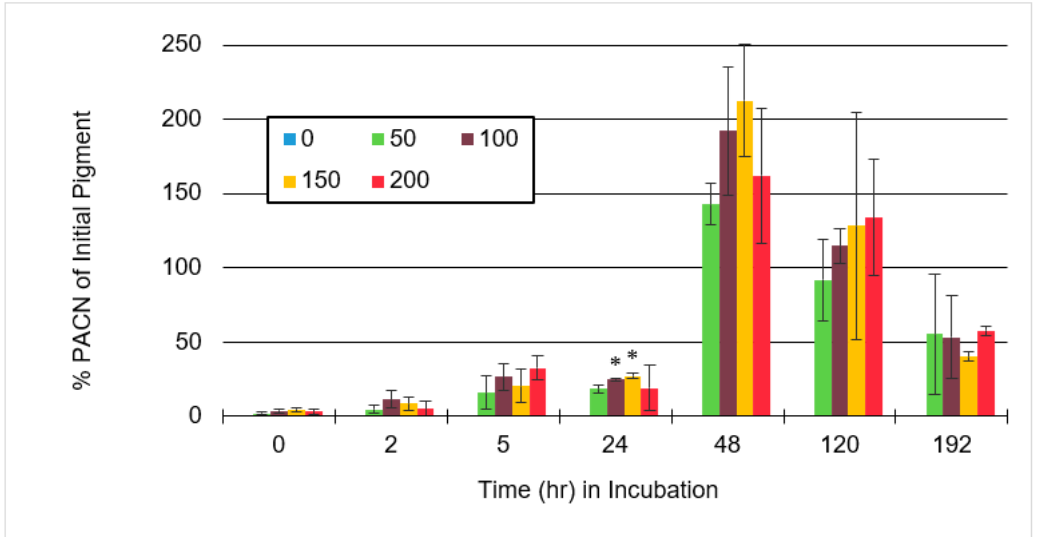
Figure 8. Average pyranoanthocyanin (PACN) concentration of initial pigment concentration in a sample containing anthocyanin to caffeic acid molar ratios of 1:0, 1:50, 1:100, 1:150, and 1:200 after hours of incubation at 65 °C. The sample without caffeic acid was not observed because there was no PACN present. Error bars represent the standard deviations. Significant difference from anthocyanin to ca ff eic acid molar ratio of 1:50 for the same incubation time with * p <